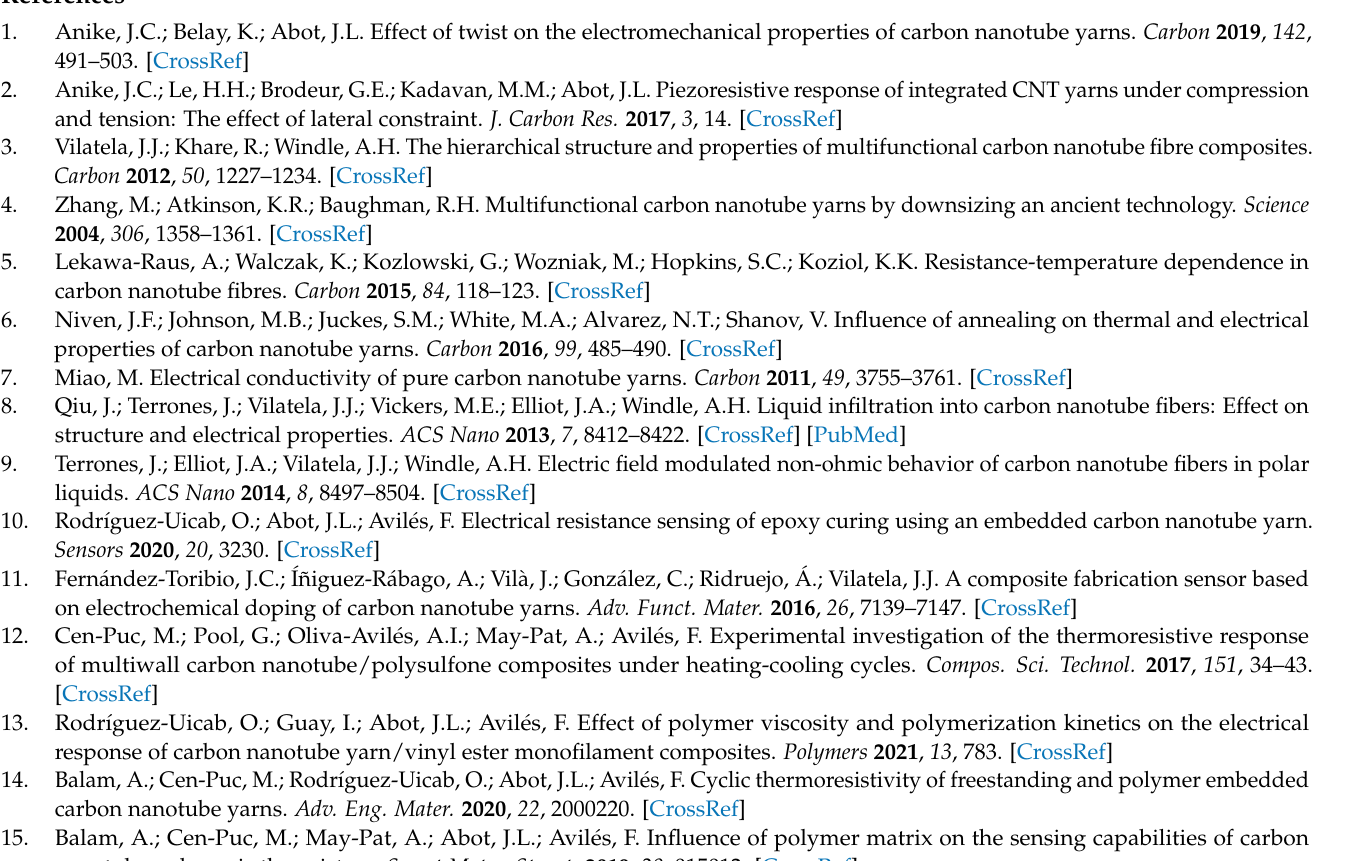
Table S1: Description of zones characterized for CNTY/SR 1 and CNTY/SR 2 , Figure S2: Heating- dwell-cooling temperature program for CNTY/SR 1 and CNTY/SR 2 , Table S2: Description of zones and parameters in heating-dwell-cooling temperature cycles, Figure S3: Cyclic temperature pro- gram for CNTY/SR 1 and CNTY/SR 2 , Table S3: Description of zones and parameters characterized for CNTY/SR 1 and CNTY/SR 2 , Figure S4: Parameters used for characterization of hysteresis of CNTY/SR 1 and CNTY/SR 2